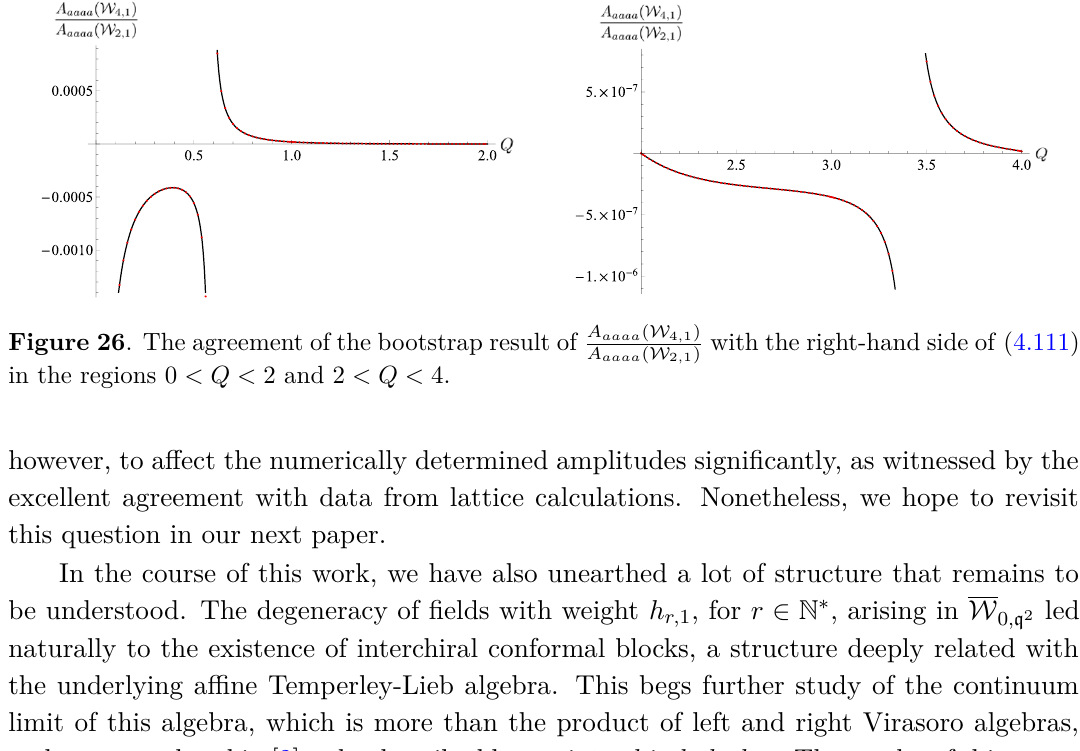
Figure 25 . The renormalized Liouville recursion of A aaaa ( W 4 , 1 ) matches perfectly with the analytic expression on the right-hand side of (4.111) (black curve).